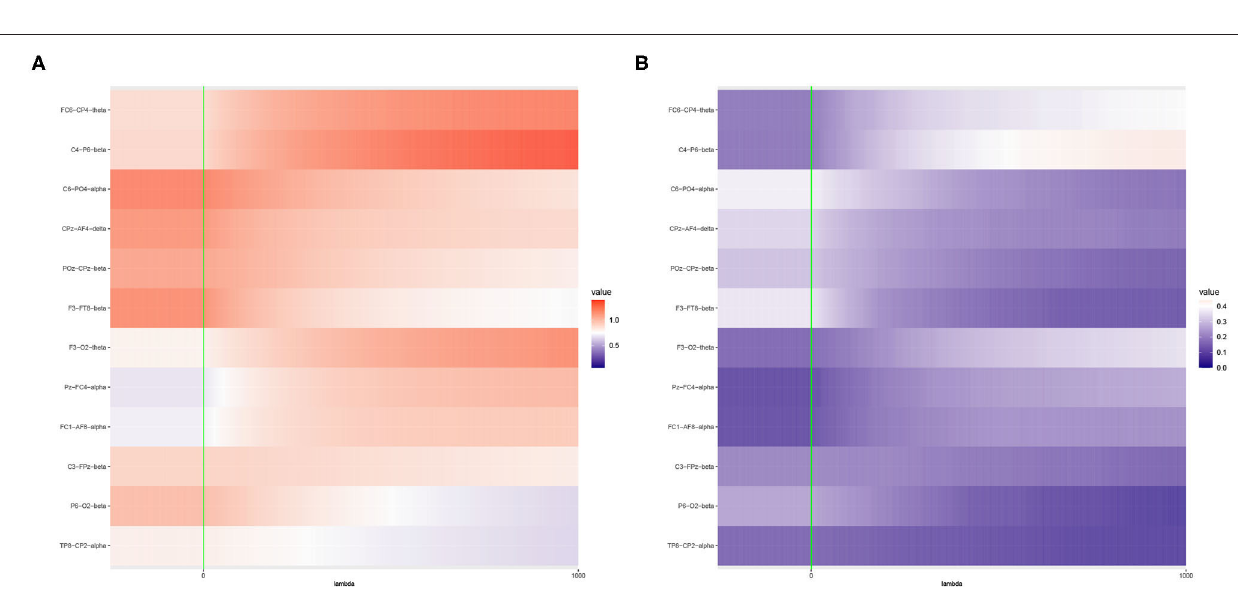
Frontiers in Neuroscience |